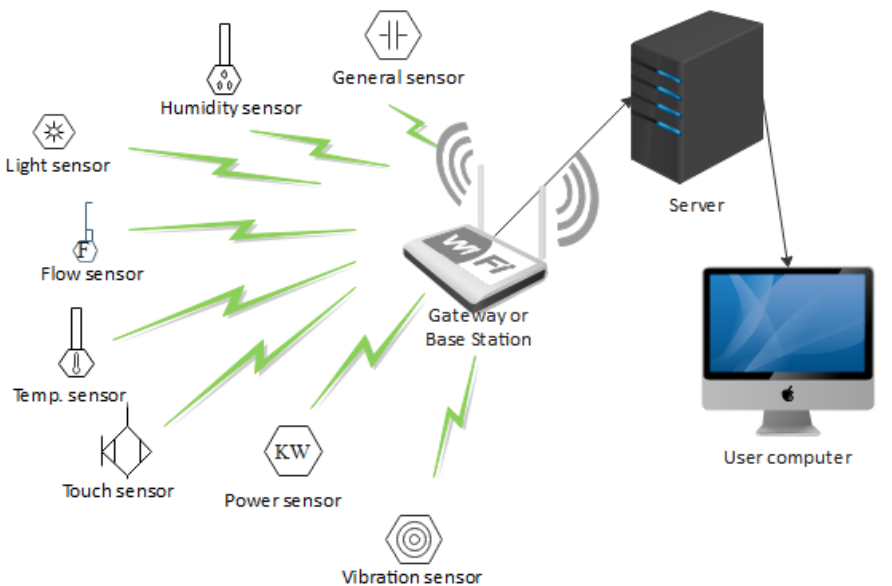
Figure 4. A WSN network architecture showing data sources, aggregation, storage, and con- trol